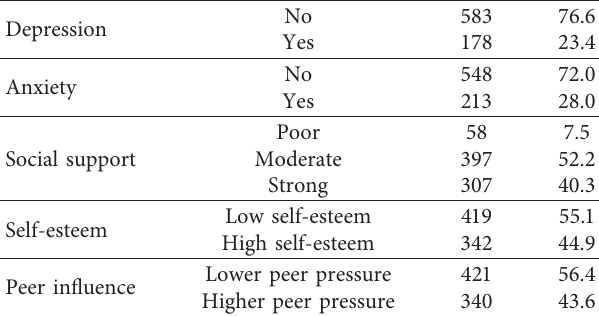
Table 3: Psychosocial and behavioral related characteristics of Dilla University undergraduate students, Dilla, Ethiopia, in